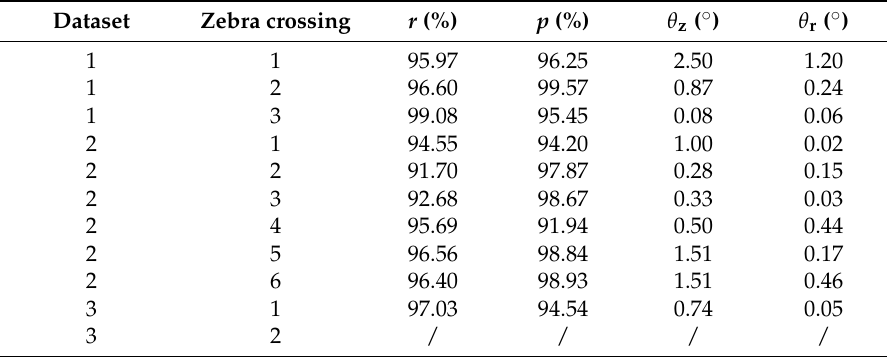
Table 4. Qualitative evaluation